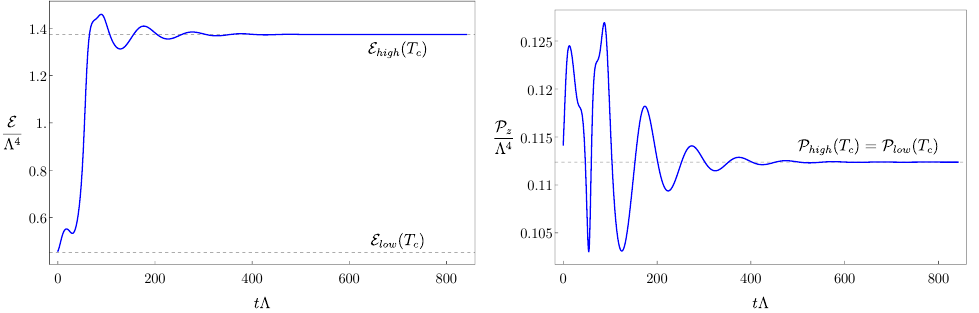
Figure 17 . (Left) Energy density E / Λ 4 and (Right) longitudinal pressure P l / Λ 4 as a function of time for constant coordinate z Λ = 0 for the evolution in figure 15.